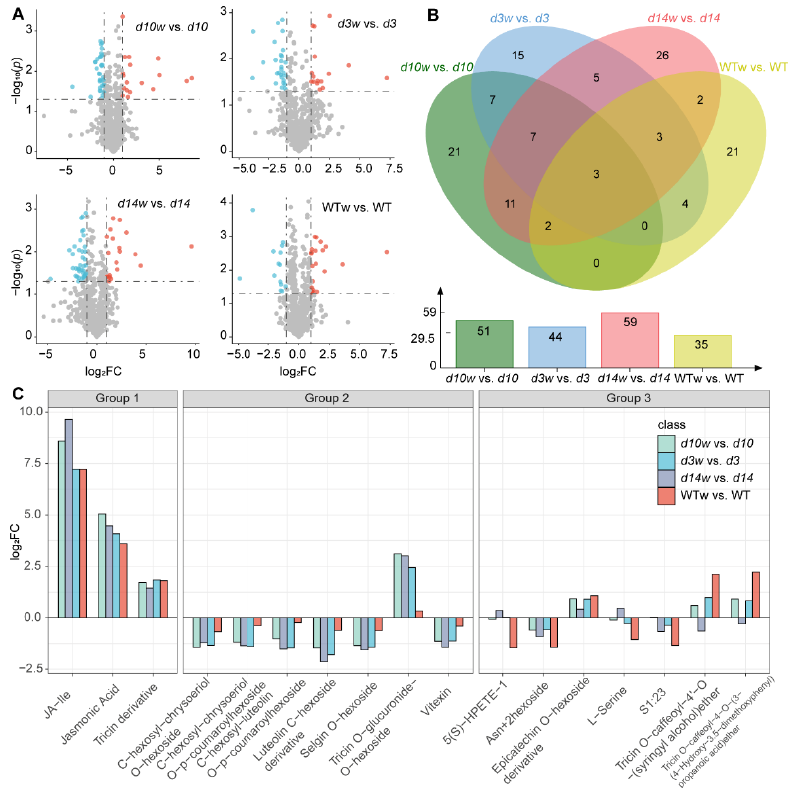
Figure 2. Schematic representation of differential accumulation metabolites (DAMs) between mutants and wild type. ( A ) DAMs in the SLs mutants ( d3 , d10 , and d14 ) and wild-type plants. ( B ) Venn diagrams showing DAMs shared between the SLs mutants and wild-type plants. ( C ) The DAMs that accumulated in each group. WTw, d3w , d10w , and d14w samples were collected 0.5 h after wounding.